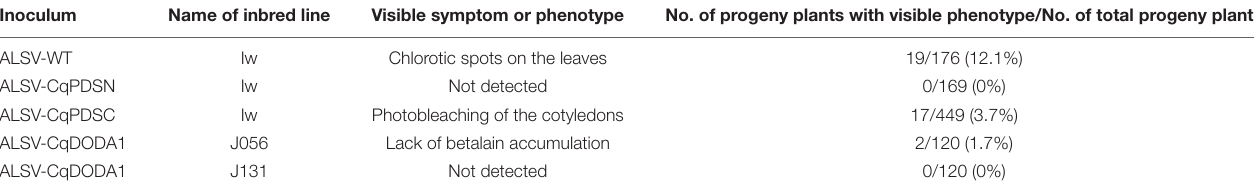
TABLE 2 | Summary of vertical transmission rates of ALSV in quinoa plants. Inoculum Name of inbred